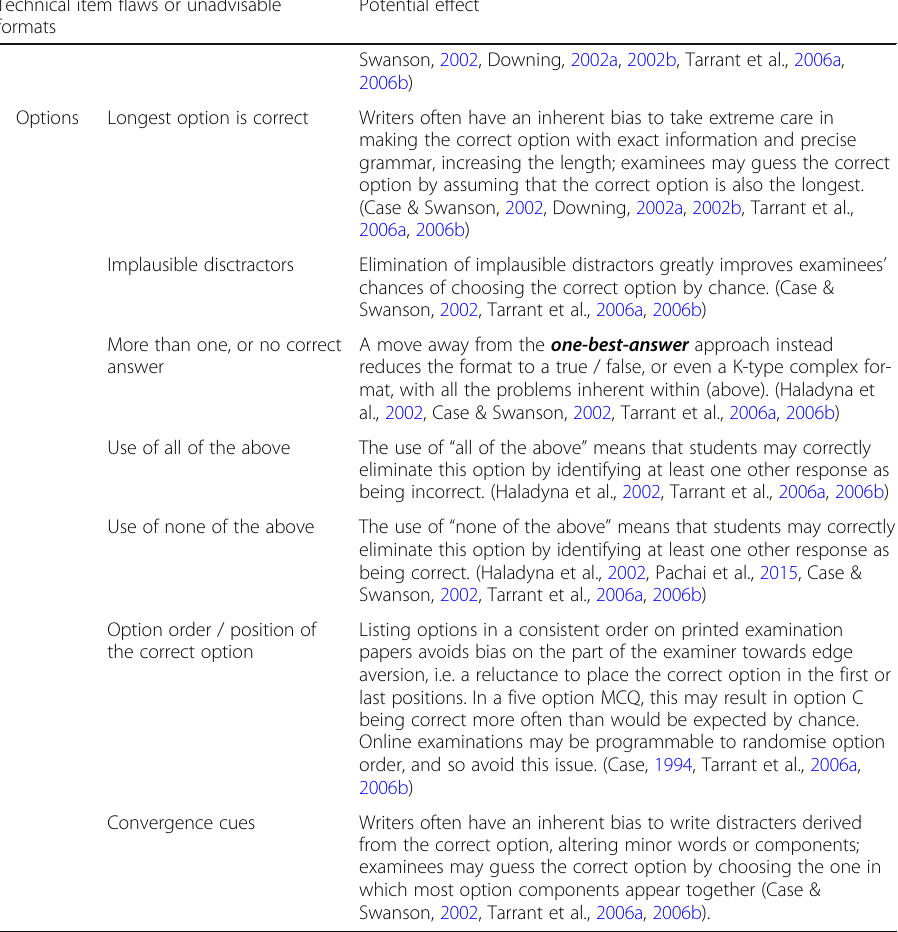
Table 1 Framework of item flaws and their potential effect